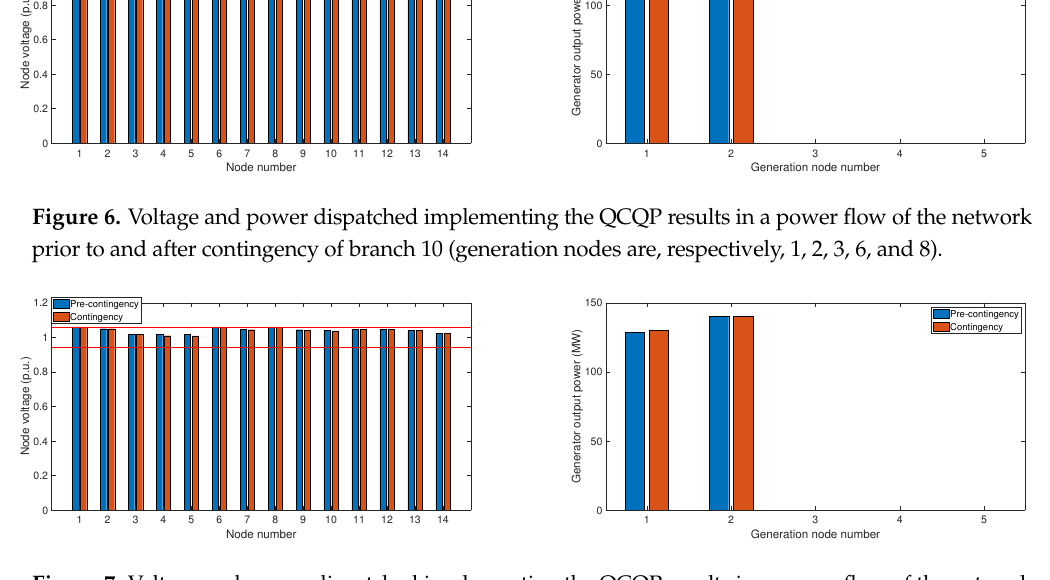
Figure 7. Voltage and power dispatched implementing the QCQP results in a power flow of the network prior to and after contingency of branch 16 (generation nodes are, respectively, 1, 2, 3, 6, and